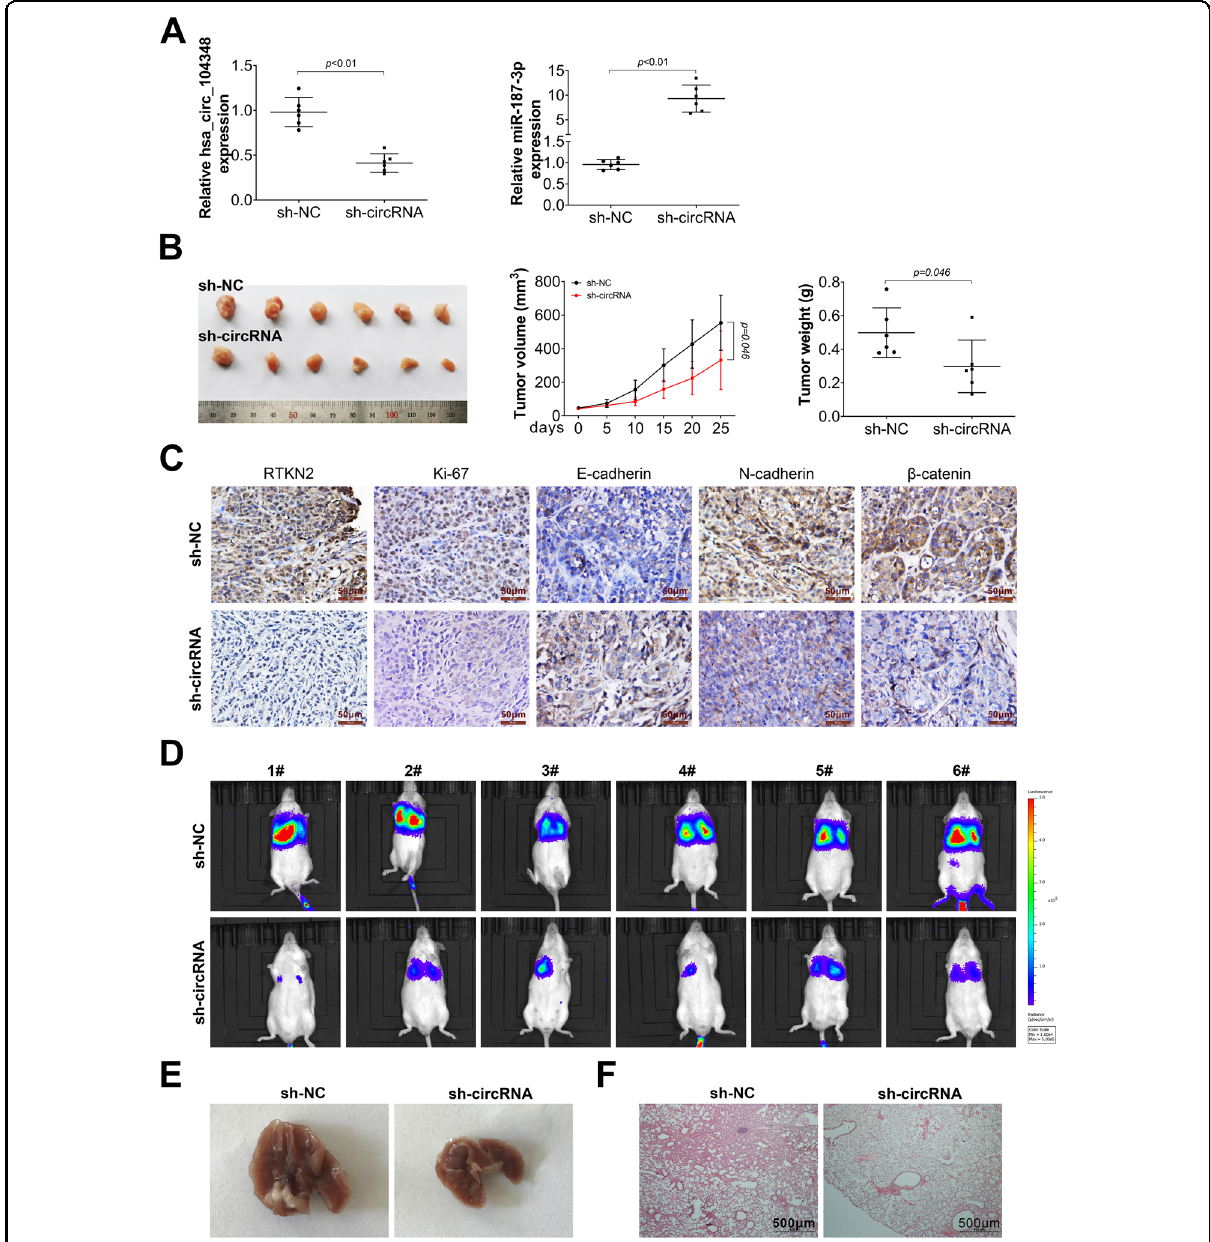
Fig. 7 Knockout of hsa_circ_104348 inhibited HCC progression in mice treated with Huh7 cell transfected with sh-circRNA or sh-NC plasmid. A The expression of hsa_circ_104348 and miR-187-3p was detected by qRT-PCR. B The effect of hsa_circ_104348 silencing on tumor volume curve and tumor weight were analyzed. C The scale bars were 50 μ m. The expression of RTKN2, β -catenin, Ki67, E-cadherin, N-cadherin was determined by IHC. D Lung metastasis was detected by in vivo images. E Metastatic focis from mice were shown. F HE-staining of pulmonary nodules from mice. The scale bars were 500 μ m. Data were expressed as mean ±